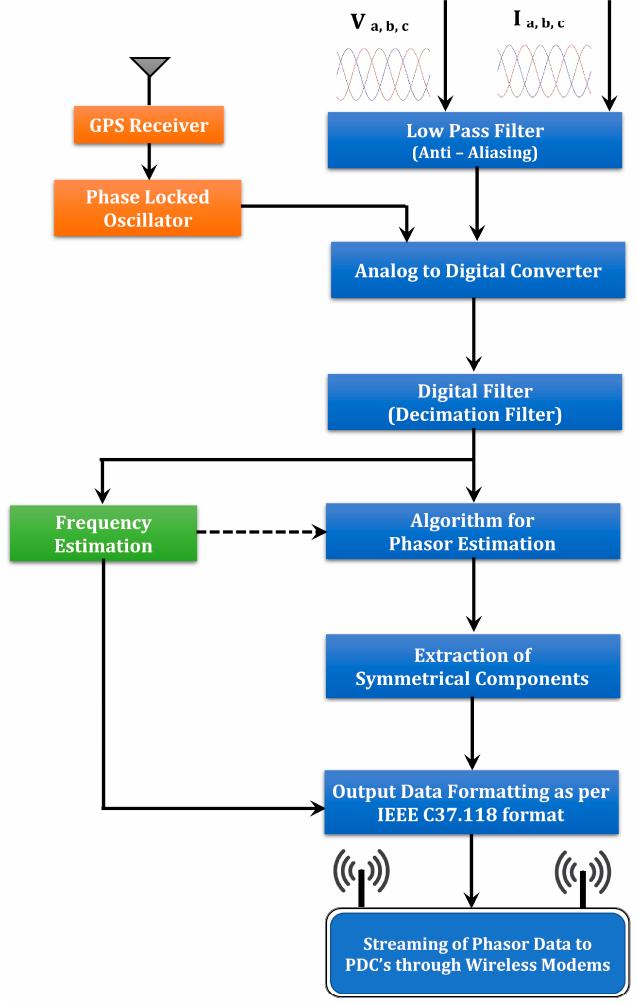
Figure 4. Block diagram of µ